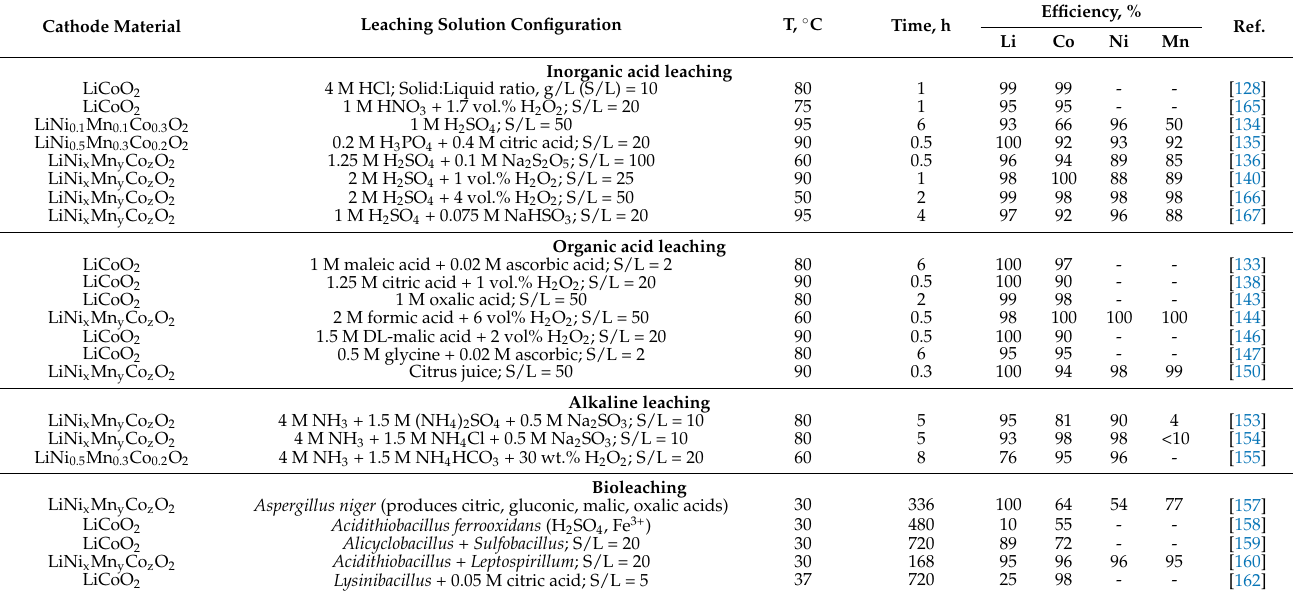
Table 1. Summary of the most efficient reported hydrometallurgical processes of LIBs. Cathode